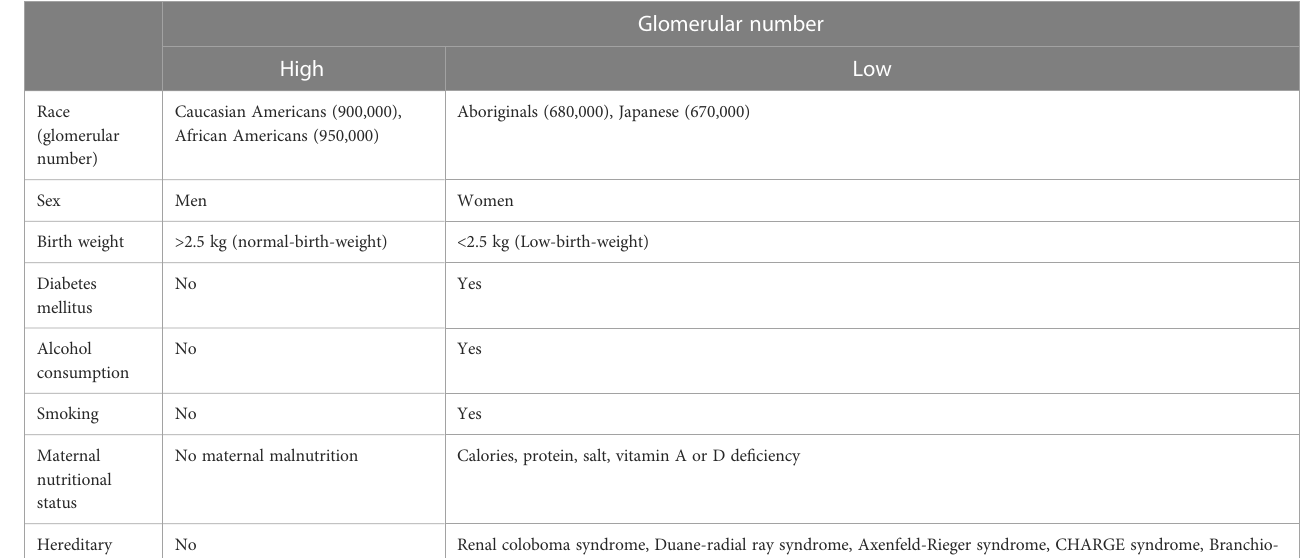
TABLE 1 Factors affecting the number of nephrons.